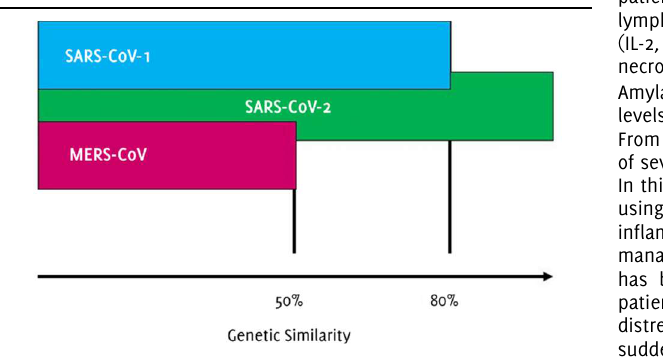
Figure 2. Genetic similarity of SARS-CoV-2 with other viruses.